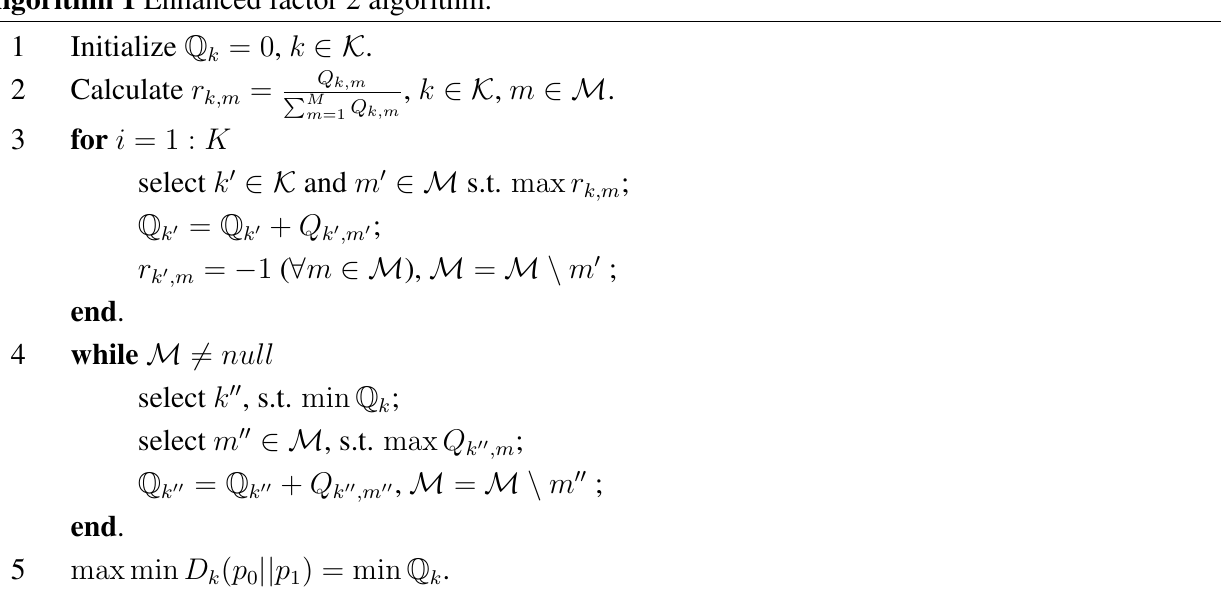
Algorithm 1 Enhanced factor 2